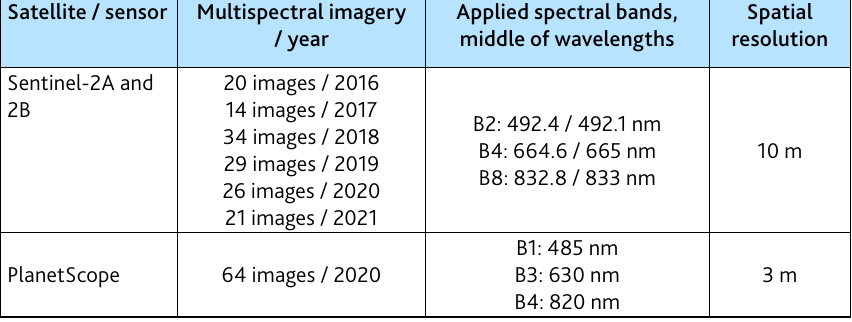
Table 1. Applied Sentinel-2 and PlanetScope imagery and their parameters Satellite /